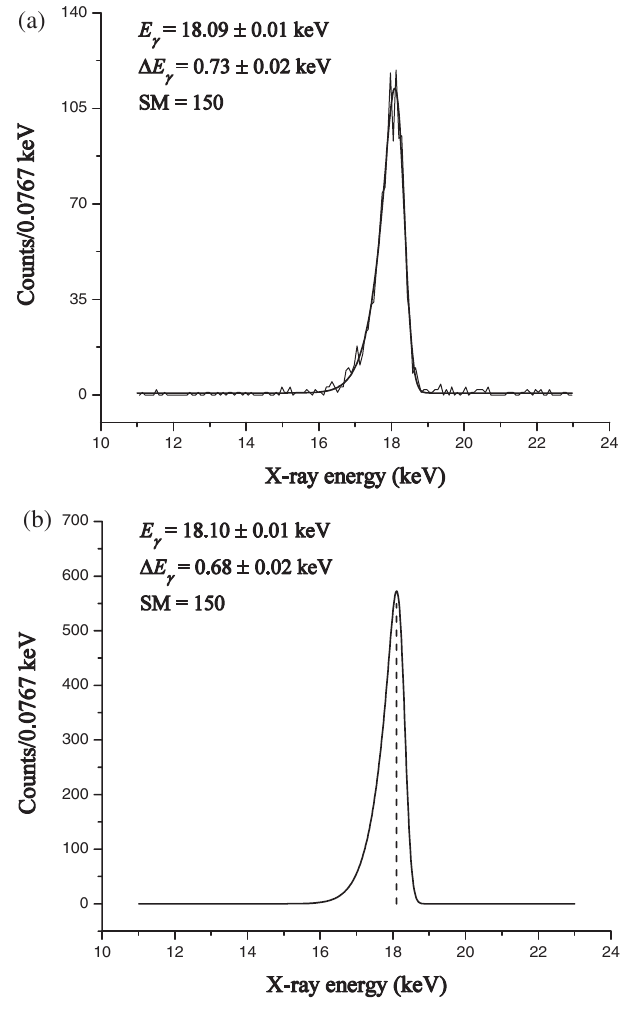
FIG. 8. (a) Fit to the experimental LCS spectrum, for a SM readout equal to 150, using the convolution of Eq. (3) with the detector response. The x-ray absorption in the SS window and air (cid:5) . (b) LCS spectrum after was included in the function F (cid:3) E (cid:1) removing x-ray absorption in different media and deconvolution with detector response. The LCS spectrum was generated using the electron beam parameters from the fit to the experimental spectrum. The vertical dashed line corresponds to the peak